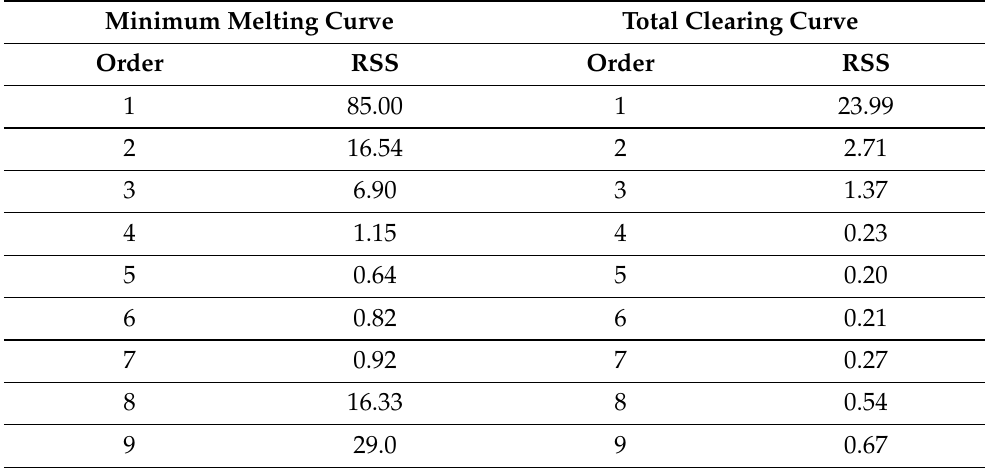
Table 1. RSS comparison of polynomial regression